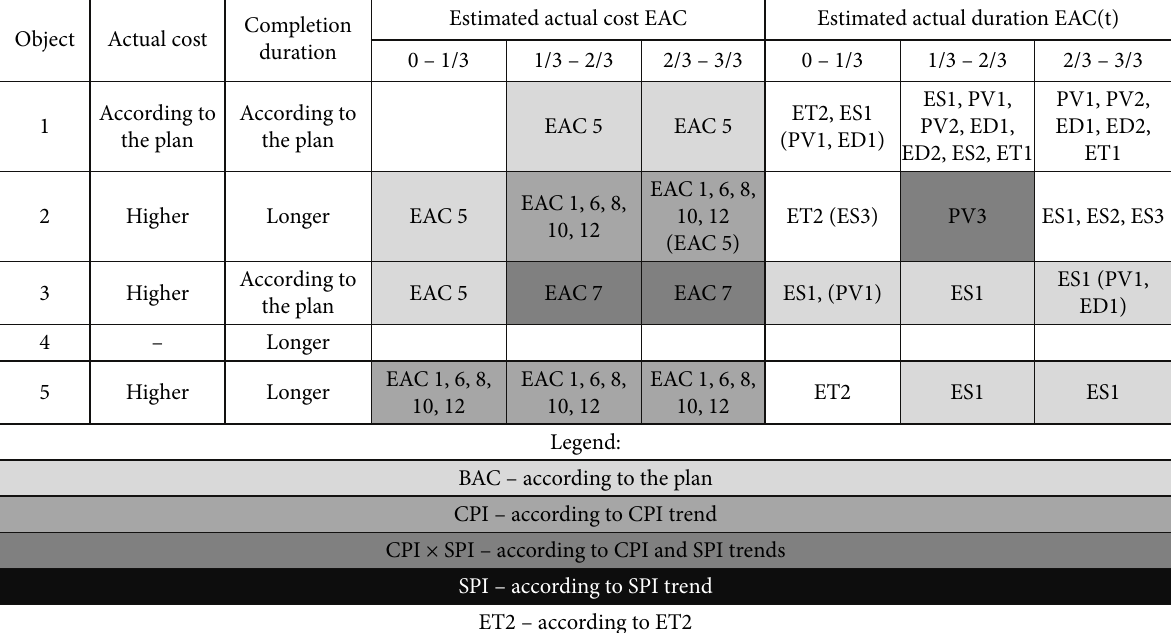
Table 2. Compilation of the most reliable results for estimating the actual cost and actual duration in subdivision of performance time into three parts (personal